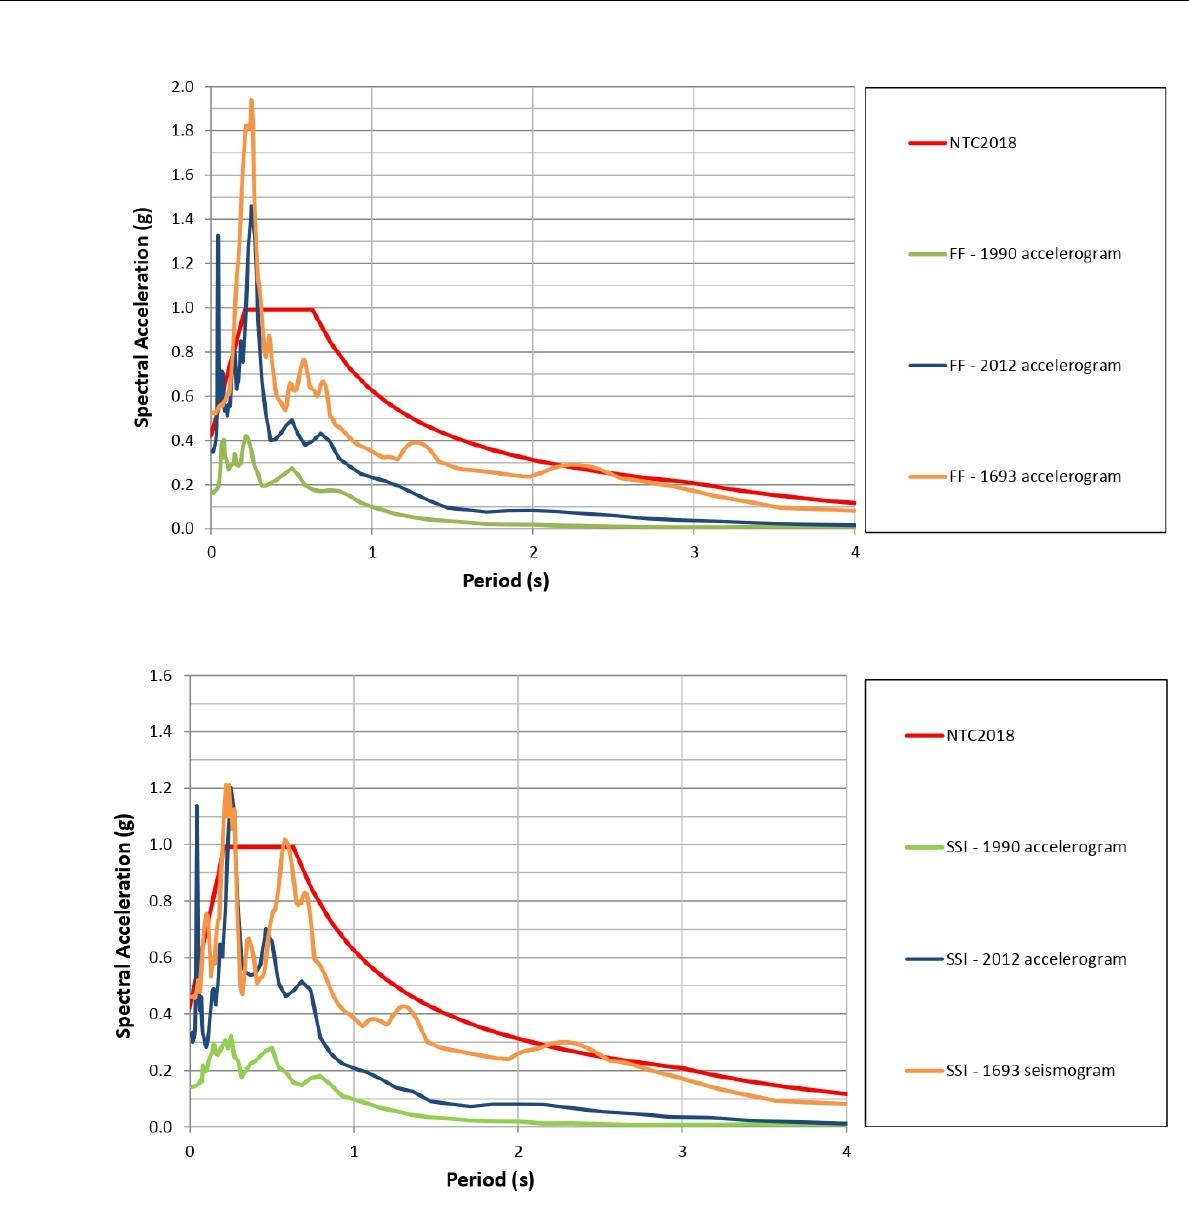
Figure 26. Comparison between the elastic response spectra obtained by numerical analyses and the same provided by NTC 2018 [51]: ( a ) FF alignment. ( b ) SSI alignment.